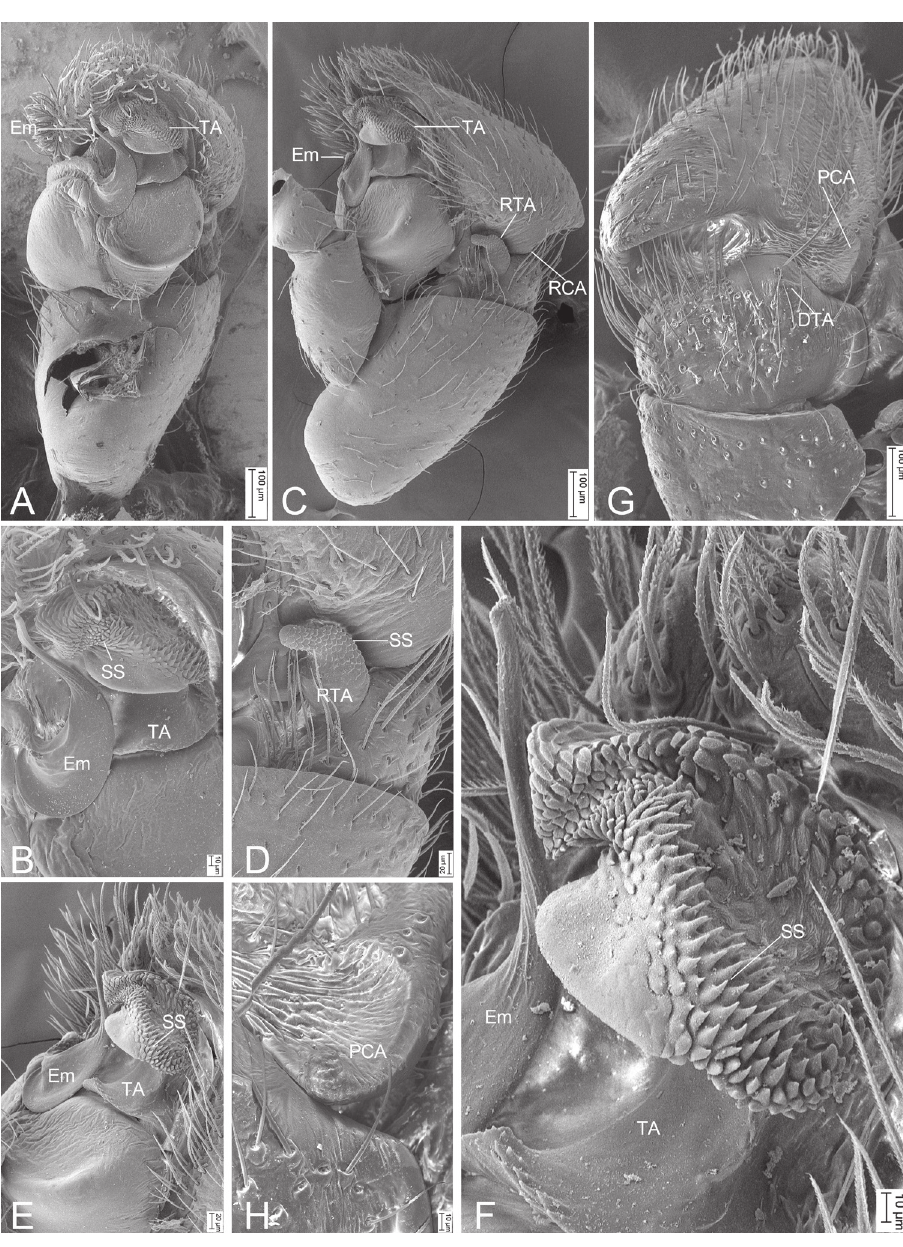
Figure 2. Synagelides emangou sp. nov., SEMs of male paratype A palp, ventral view, slightly frontal B same, detail of terminal apophysis and embolus, ventral view, slightly frontal C same, retrolateral view D same, detail of retrolateral tibial apophysis, retrolateral view E same, detail of terminal apophysis and embolus, retrolateral view F same, detail of terminal apophysis and embolus, retrolateral view G same, dorsal view H same, detail of postero-prolateral cymbial apophysis, dorsal view. Abbreviations: DTA – dorso-prolateral tibial apophysis, Em – embolus, PCA – postero-prolateral cymbial apophysis, RCA – postero-retrolateral cymbial apophysis, RTA – retrolateral tibial apophysis, SS – scale-like serrations, TA – terminal